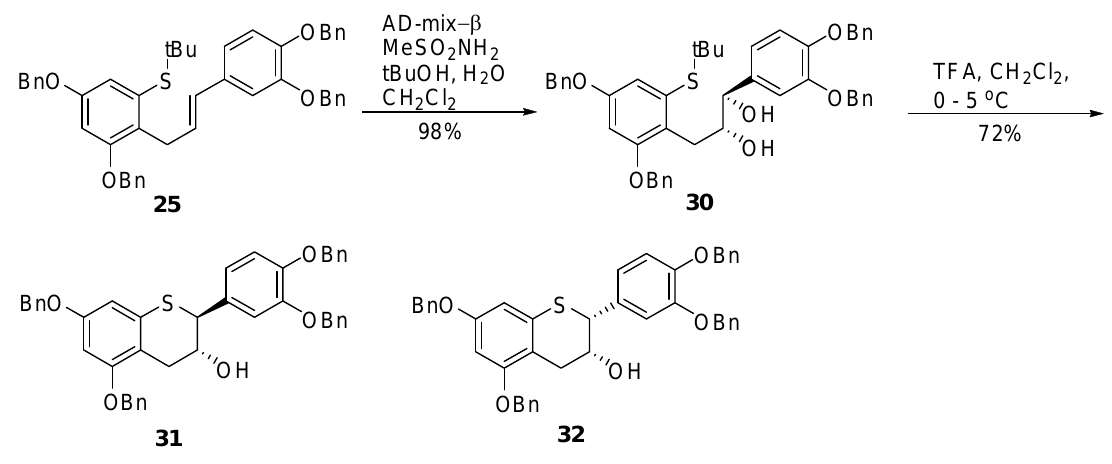
Scheme 6. Synthesis of intermediates 31 and 32 .